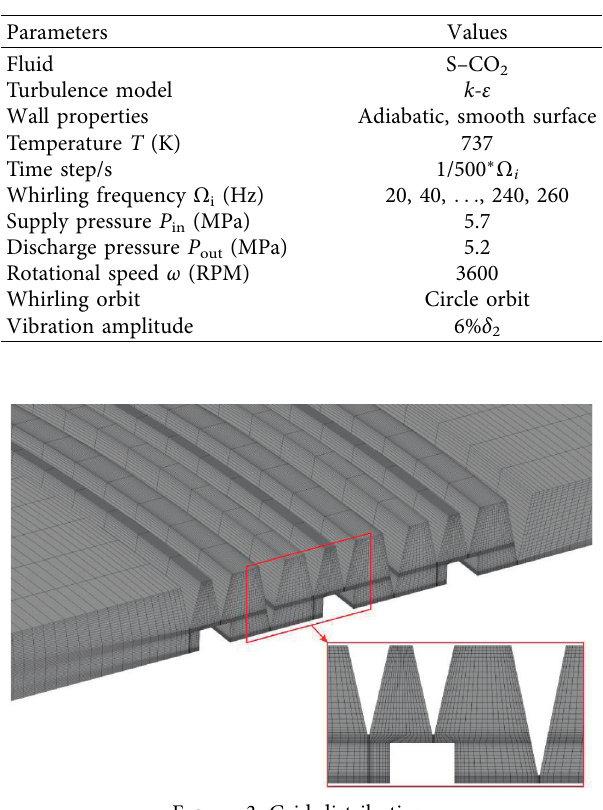
Table 3: Calculation